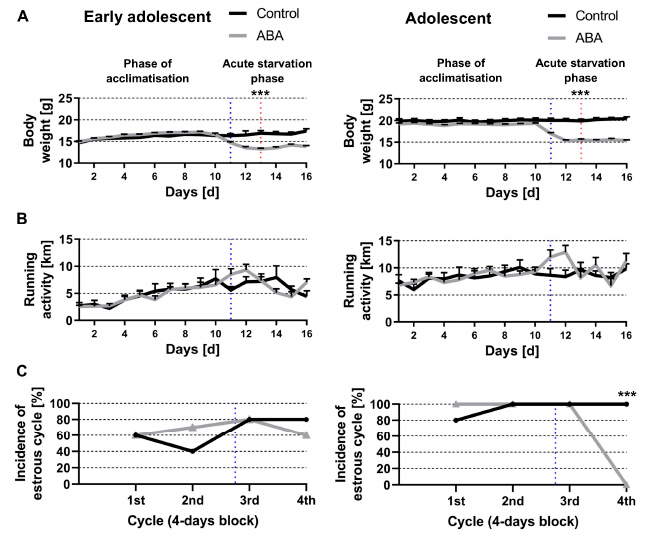
Figure 3. Acute starvation induces amenorrhea in adolescent mice. ( A ) The body weight, ( B ) running wheel activity measured by sensors, and ( C ) incidence of estrous cycle determined by histological examination of vaginal smears during acute starvation in early adolescent (left) and adolescent mice (right). The blue dotted lines represent the start of acute starvation phases and the red dotted line when ABA groups achieved a 20% body weight loss. The occurrence of the estrous cycle was determined in 4-day blocks based on the normal duration of the cycle in mice. ( A , B ) *** p ≤ 0.001, two-way ANOVA with repeated measurements. ( C ) Chi-squared tests comparing the incidence of the estrous cycle in ABA and control mice.